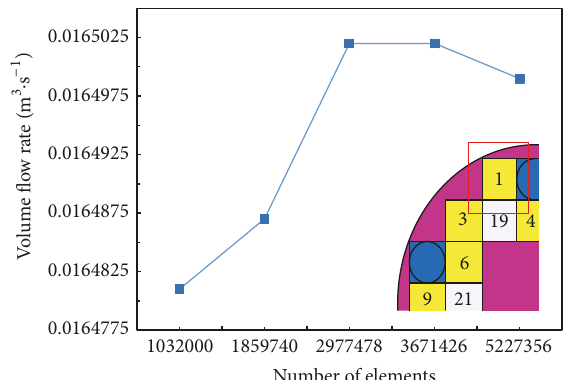
Figure 5: Volumetric flow rate in channel 1 for various numbers of elements.